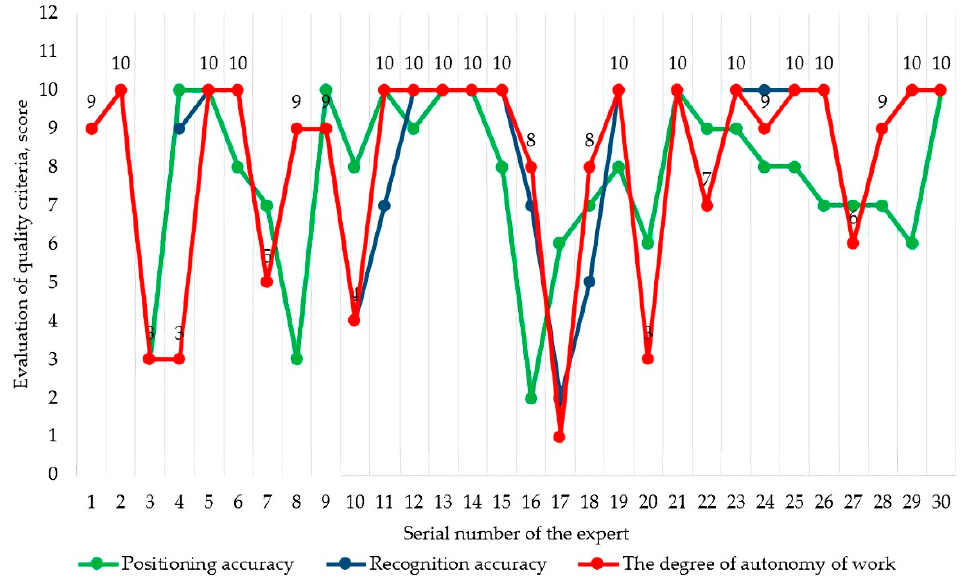
Figure 13. Ranking of priority factors.